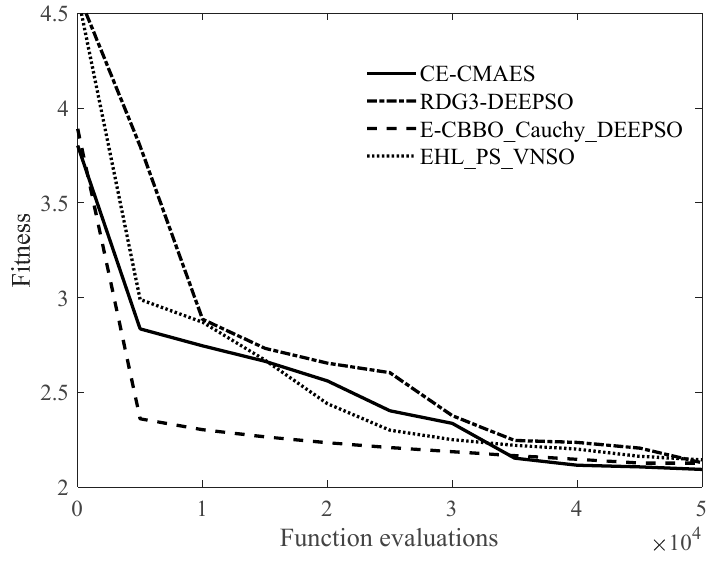
Figure 7. Convergence of fitness over number of function evaluation.